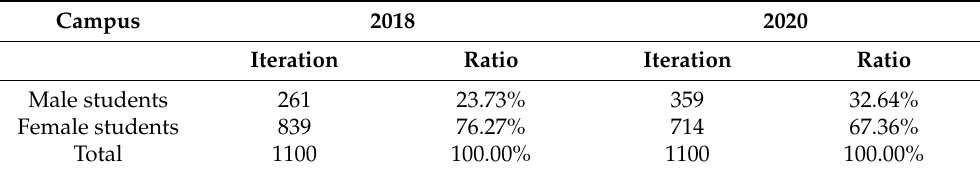
Table 2. Distribution of student numbers by campus between 2018 and 2020 survey periods.